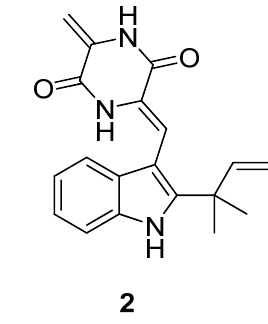
Figure 1. Chemical structures of neoechinulins A ( 1 ) and B ( 2